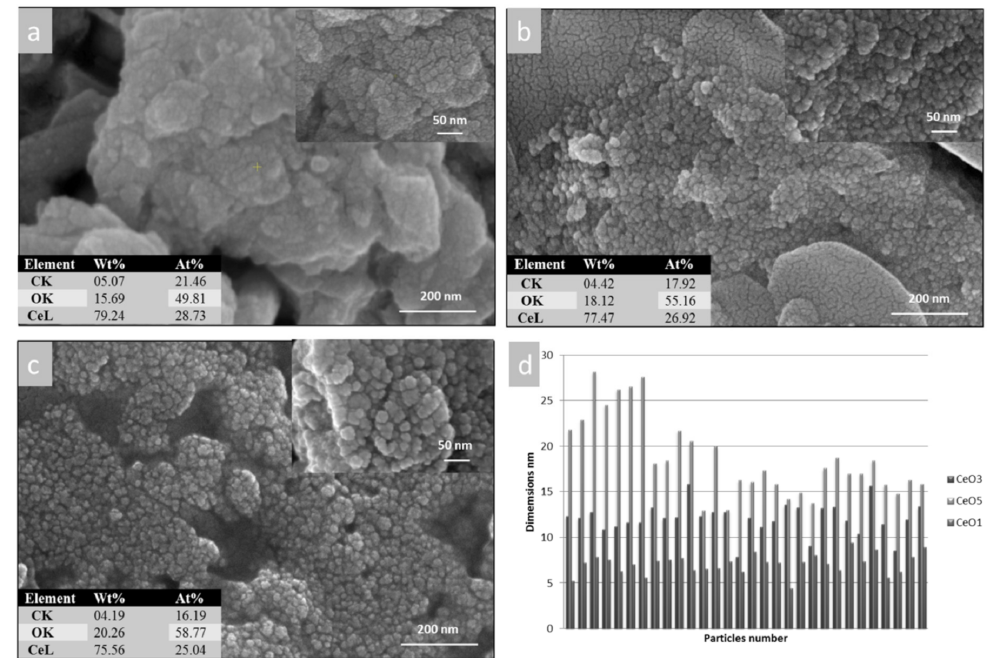
Figure 2. Morphology with elemental composition of synthetized nanoparticles: ( a ) CeO-1, ( b ) CeO-2, ( c ) CeO-3, ( d ) histogram with the particles size, as measured by Image j